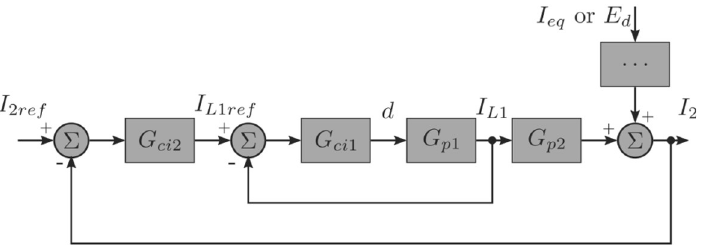
Figure 4. Control scheme that is used for the current control of the ESS converter in scenarios #4 (SC-GD) and #5